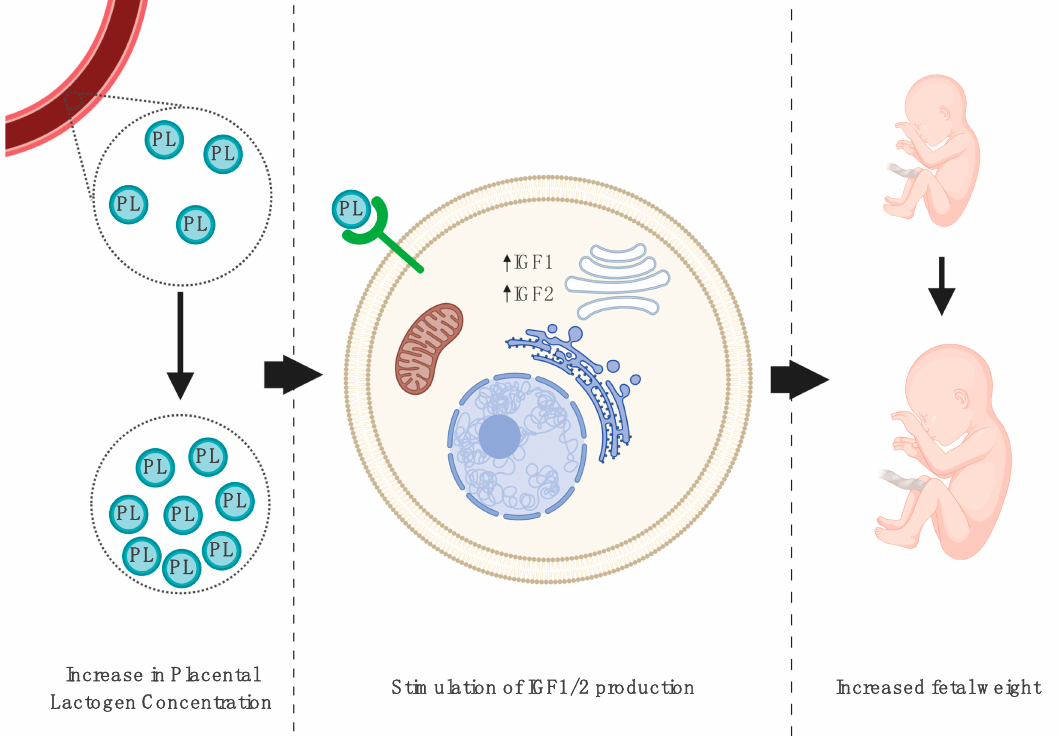
Figure 2. The influence of increased blood placental lactogen (PL) levels on tissues of the developing fetus. Elevated PL concentrations throughout pregnancy are correlated with an increased secretion of insulin-like growth factor-1 (IGF-1) and insulin-like growth factor-2 (IGF-2), which directly corresponds to an increased fetal weight [95]. Created with BioRender.